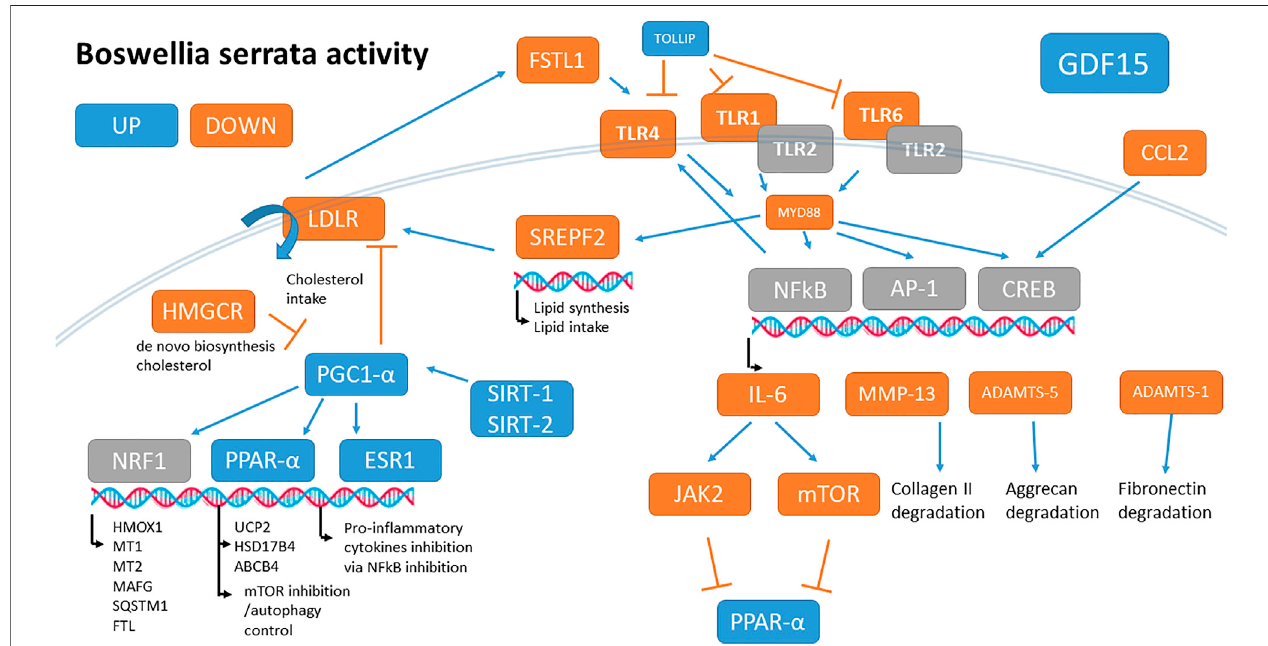
FIGURE2 | Summary ofmain B. serrata activitieson OA chondrocytes after 24 h oftreatment. Genes in blue are up-regulated,in orange are down-regulated, and in grey are